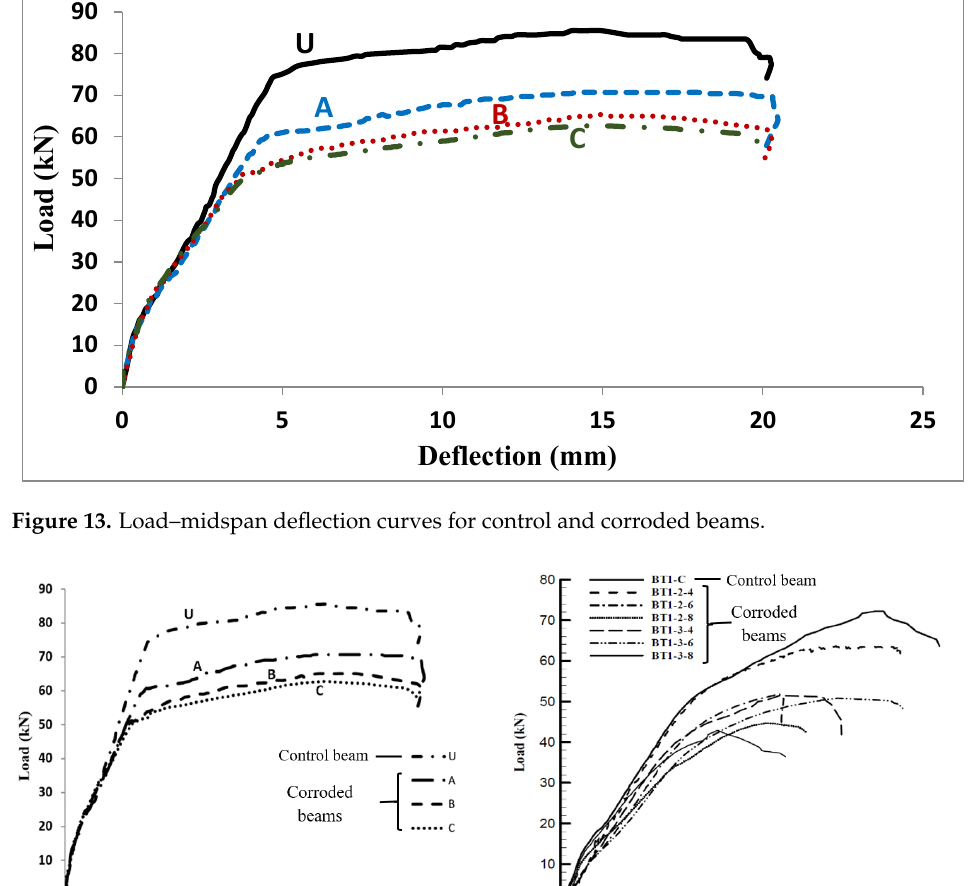
( d ) Figure 12. Failure modes of control and corroded RC beam specimens ( a ) control beam ; ( b ) beam A ; ( c ) beam B ; ( d ) beam C . Plots of the results of flexural testing (i.e., load versus mid ‐ span deflection curves) conducted on the control RC beam ( U ) and corroded RC beams ( A , B , and C ) are shown